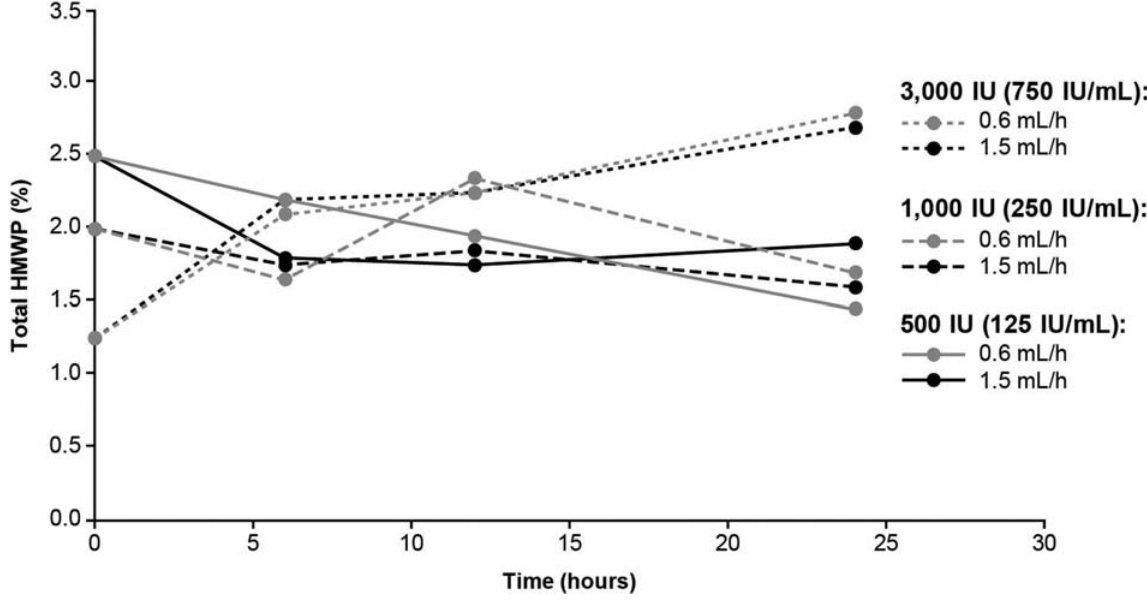
Fig. 4 The total HMWP content of turoctocog alfa was assessed during 24 hours of CI at pump speeds of 0.6 and 1.5 mL/h. The following turoctocog alfa samples were assessed: 500 IU (equating to 125 IU/mL), 1,000 IU (equating to 250 IU/mL), and 3,000 IU (equating to 750 IU/mL). CI, continuous infusion; HMWP, high molecular-weight